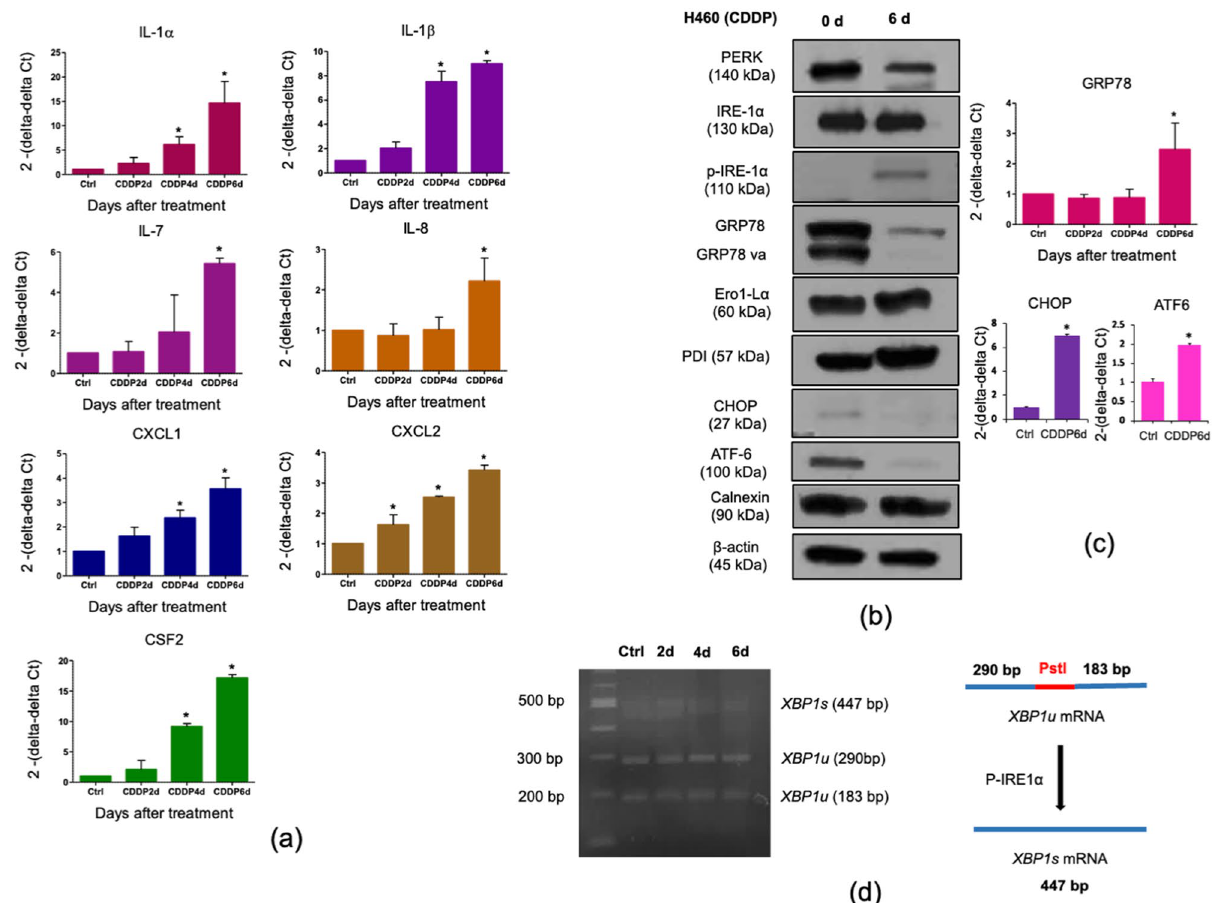
Figure 3. CDDP-induced SASP in H460 and non-cytoprotective unfolded protein response. ( a ) Time-course analysis of the relative mRNA levels of various SASP genes by real-time Q-PCR in H460 cells treated with CDDP at 5 µM. ( b ) Protein expression levels of ER stress markers were detected in CDDP induced H460 senescence cells during SASP by western blot analysis (the full-length blots are presented in Supplementary Figures) ( c ) Time-course analysis of the relative mRNA levels of GRP78, CHOP and ATF-6 by real-time Q-PCR in H460 cells treated with CDDP at 5 µM. ( d ) H460 cells were treated with 5 µM CDDP at the respective days indicated. The cDNA from total RNA from these cells was subjected to PCR and Pst1 restriction digestion (CTGCA|G) to semi-quantitatively evaluate the levels of XBP1s . XBP1u unspliced XBP1 , XBP1s spliced XBP1 . For all the data, the average of three independent experiments is shown. Data was analyzed by two-tailed Student’s t-test. *Denotes p < cell proliferation but not for H460 (Fig. 4b) until 18 days after the CDDP treatment. Suggesting that GRP78 may contribute to the reversible senescence phenotype.